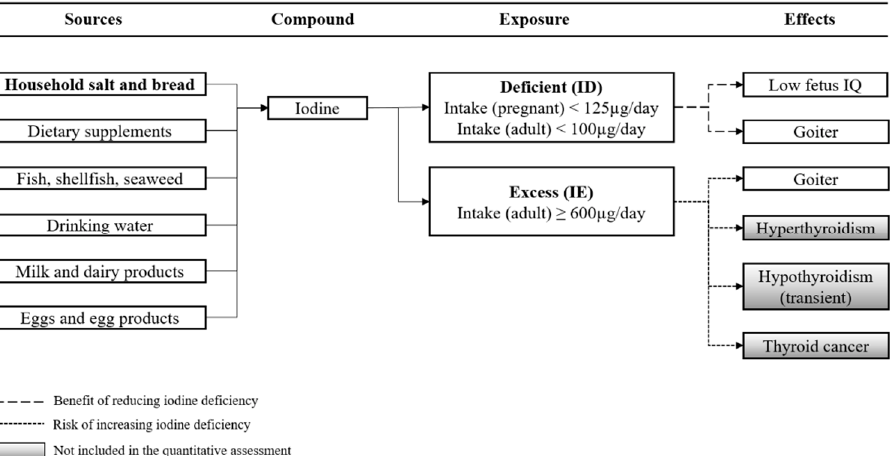
Figure 1. Conceptual model relating dietary sources of iodine to iodine nutrition status and related health effects. Bold text indicates iodine fortification. Beneficial effects are represented by reducing iodine deficiency and the prevention of health effects; adverse effects are represented by increasing excess iodine intake and causing health effects. Health effects in gray boxes are not included in the quantitative risk–benefit